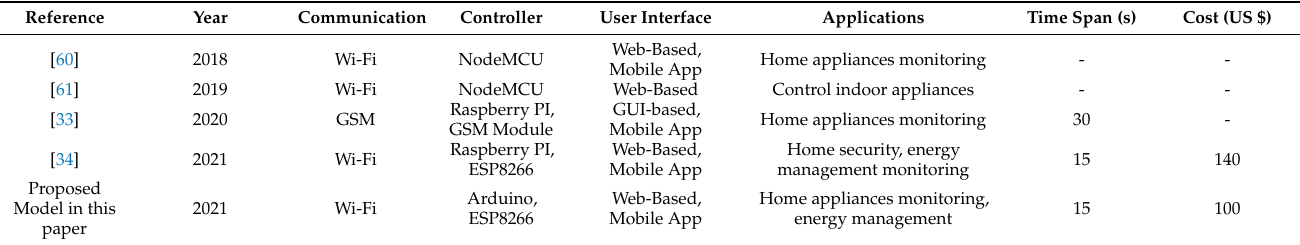
Figure 9. ( a ) Creating a new project in Blynk apps; ( b ) Complete visualisation of ISHDB parameters. Table 2. Comparison of the proposed method with other existing